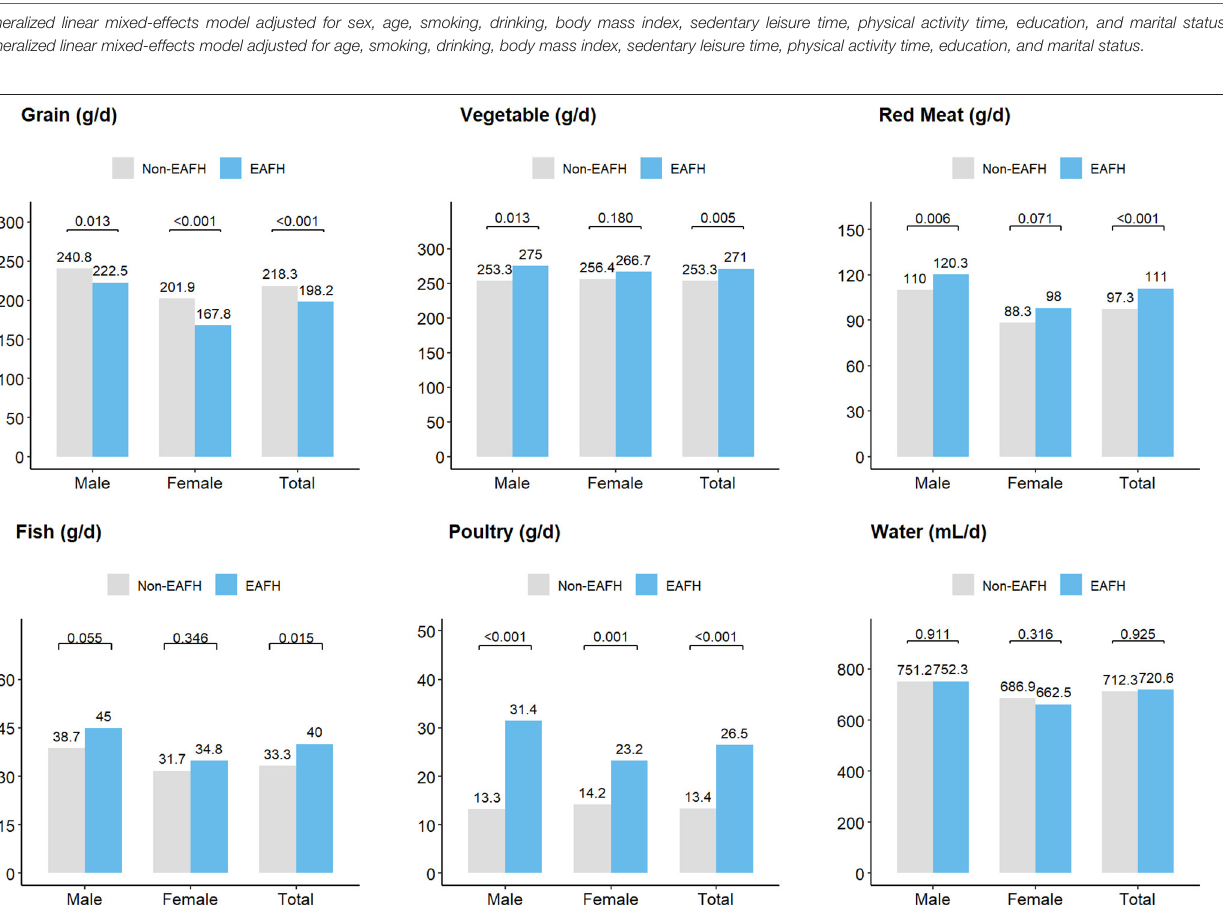
FIGURE 3 | Food intake (g/d) among different populations. EAFH, Eating away from